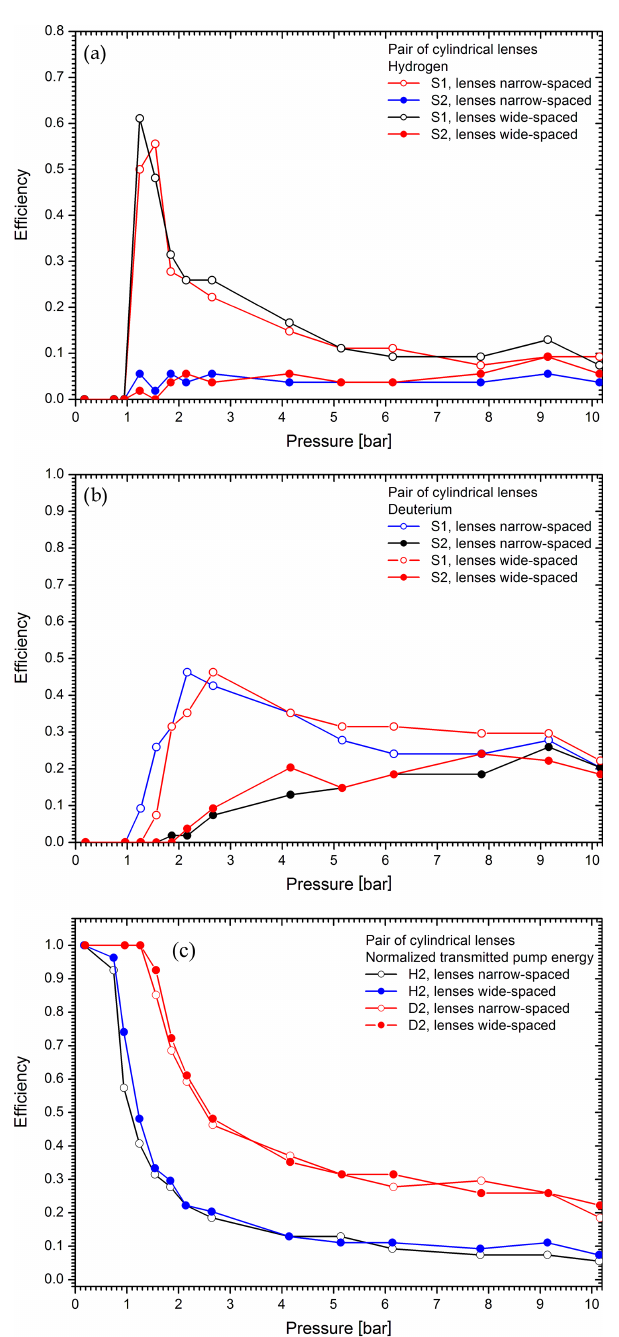
Figure 6. Raman conversion efficiencies and pump beam depletion for a pair of crossed f = 1 . 0m cylindrical lenses: (a) S1 and S2 in hydrogen; (b) S1 and S2 in deuterium; (c) normalized transmitted pump energy in both H 2 and D 2 .